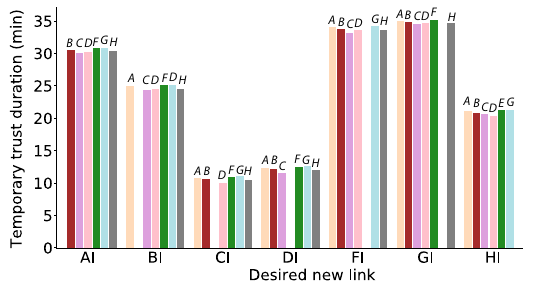
FIG. 6. We show that initial authentication, while adding a new user to the network, can be established in less than 35 min. The figure corresponds to a demonstration in which a fully con- nected network of seven users exists and a new user— I —wishes to join the network using the SIAT protocol. The time in any other user must be trusted, when used as an intermediary node in order to connect I to different end users is shown. The end users are shown on the x-axis and intermediaries are denoted by differ- ent colours and labelled above the bars. The data used are taken from Ref.